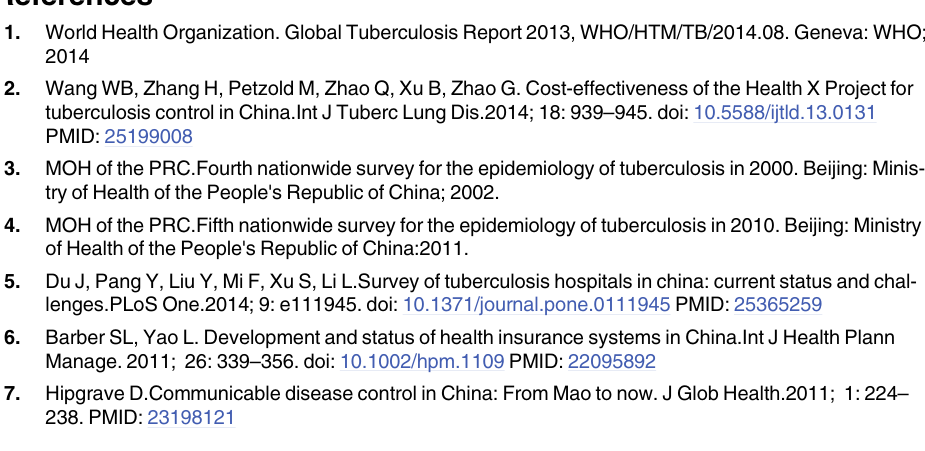
S1 Table. Number of TB in-patientsamong different regions of China. S2 Table. GDP per person in 1999, 2004 and 2009 among different regions of